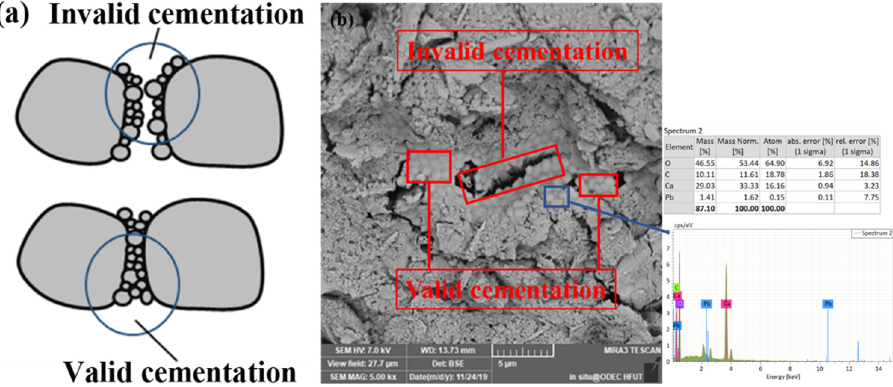
Figure 6. ( a ) Schematic and ( b ) SEM images showing valid and invalid cementation.